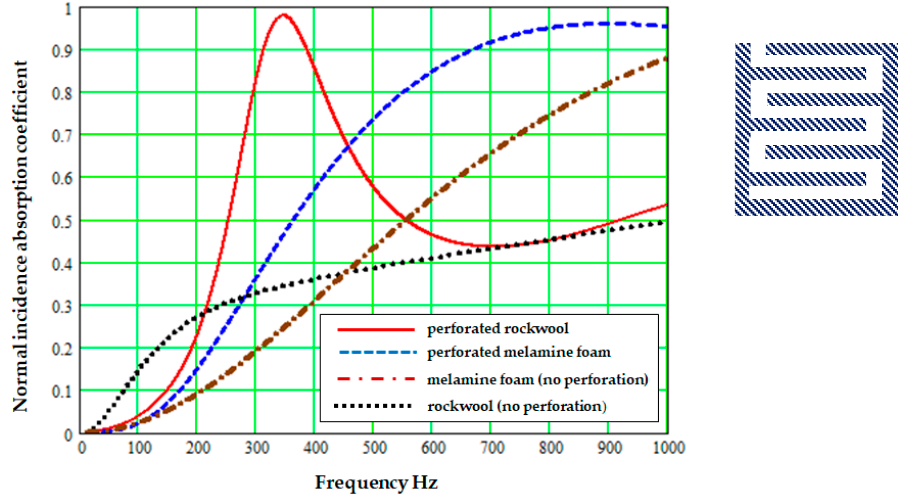
Table 1. JCAL model parameter values assumed for rockwool [2] and melamine foam [9]. Material/Parameter